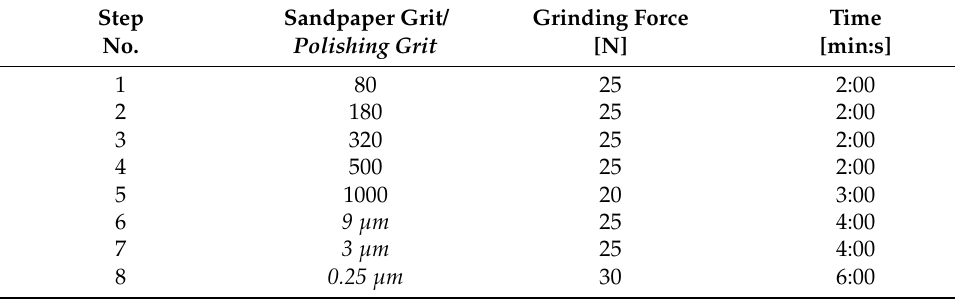
Table A4. Single steps of metallographic